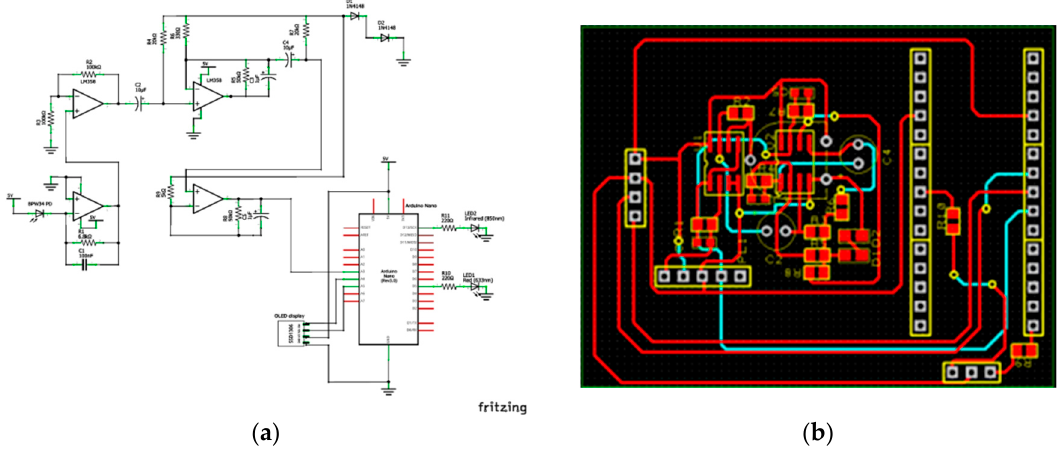
Figure 19. External circuitry. ( a ) Schematic diagram of external circuitry used to control the LEDs and acquire the PD signal; ( b ) PCB design of the external circuitry.